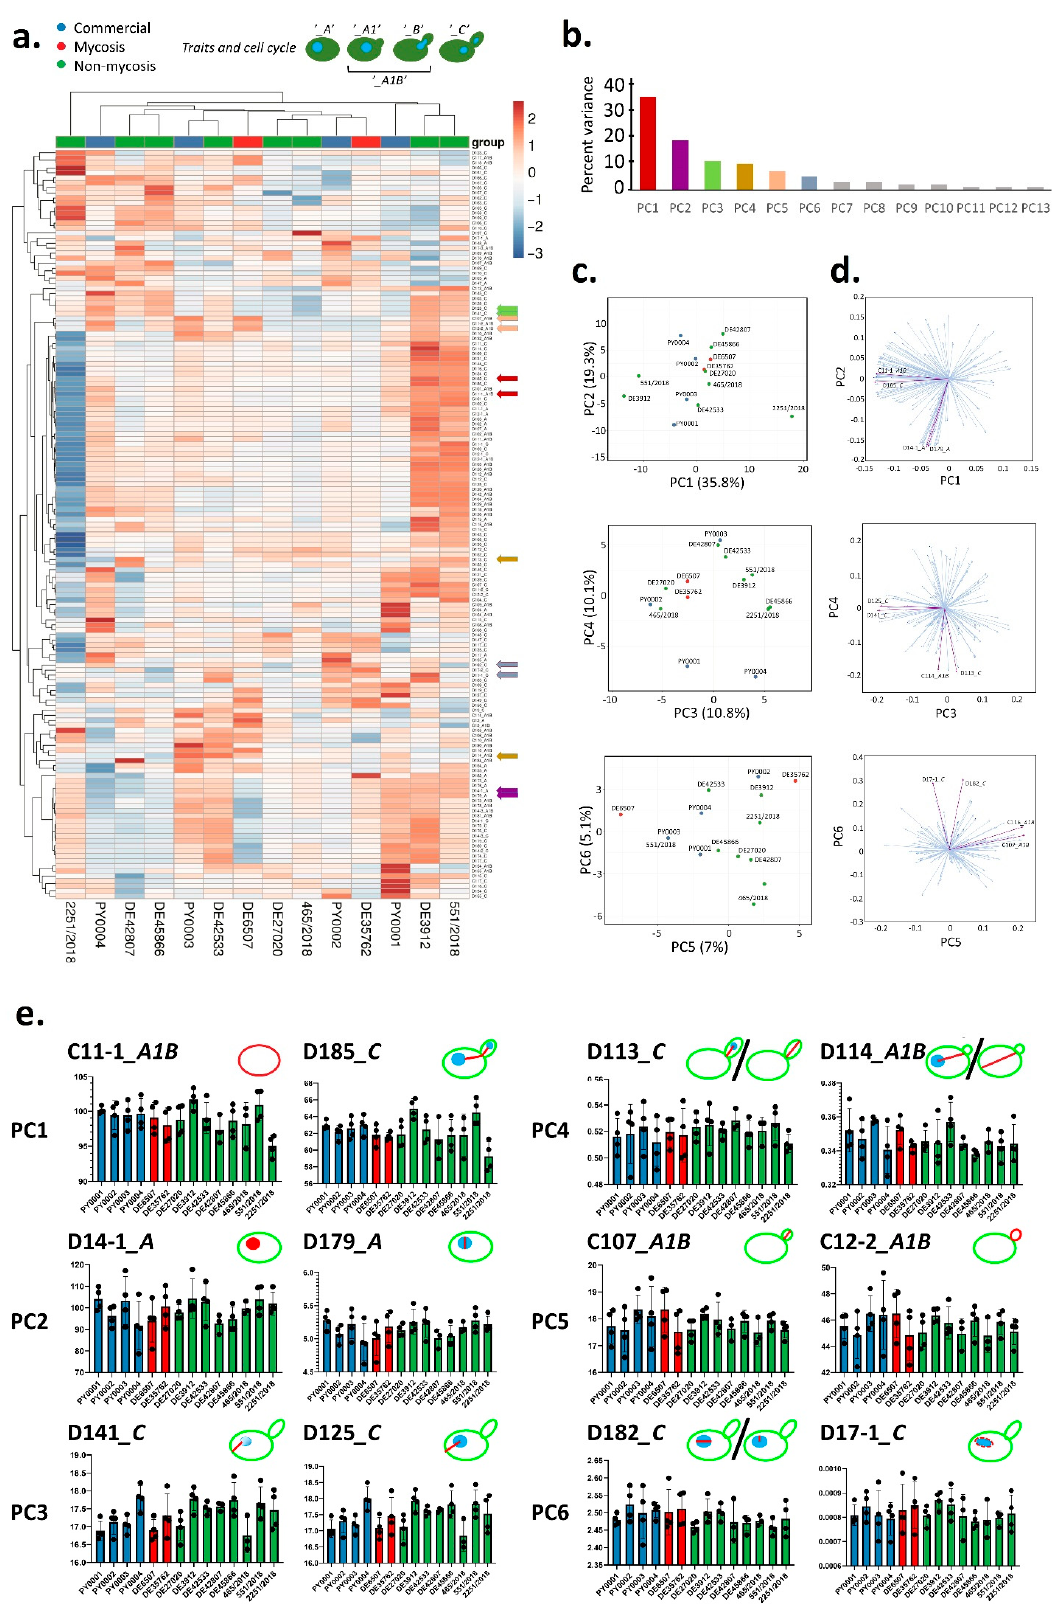
Figure 2. Evaluation of high-throughput single-cell phenotyping data. ( a ) Phenotypic clustering of measured traits, with unit variance scaling applied to rows. Rows are clustered using correlation distance and average linkage. Columns are clustered using Euclidean distance and average linkage. Trait groups according to cell cycle are explained in the form